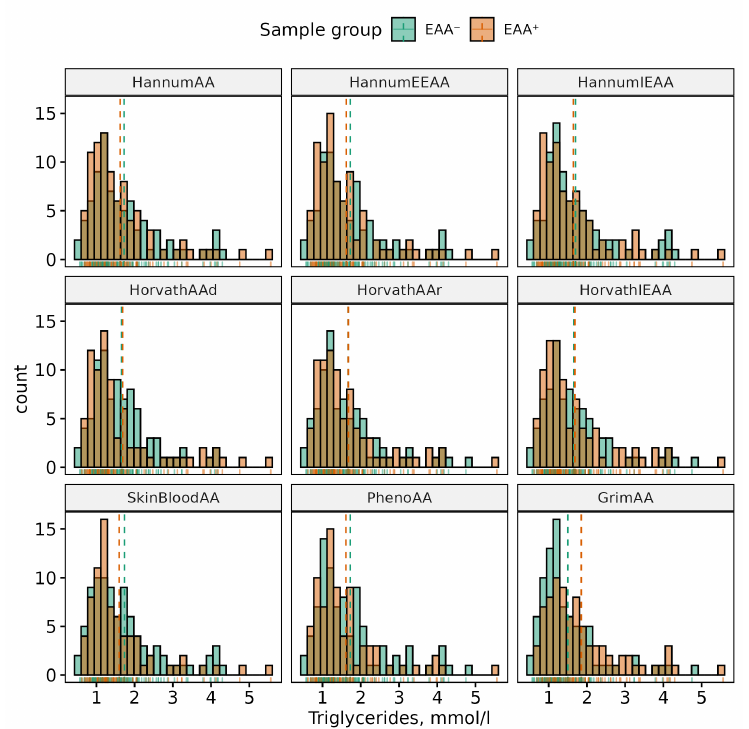
Figure A10. Histograms of distributions of TG levels in females in EAA + and EAA − groups. Dashed lines correspond to the group